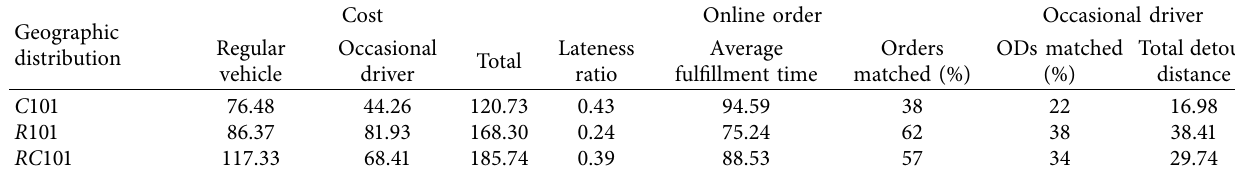
Table 9: Comparison of different geographic distributions of online orders.